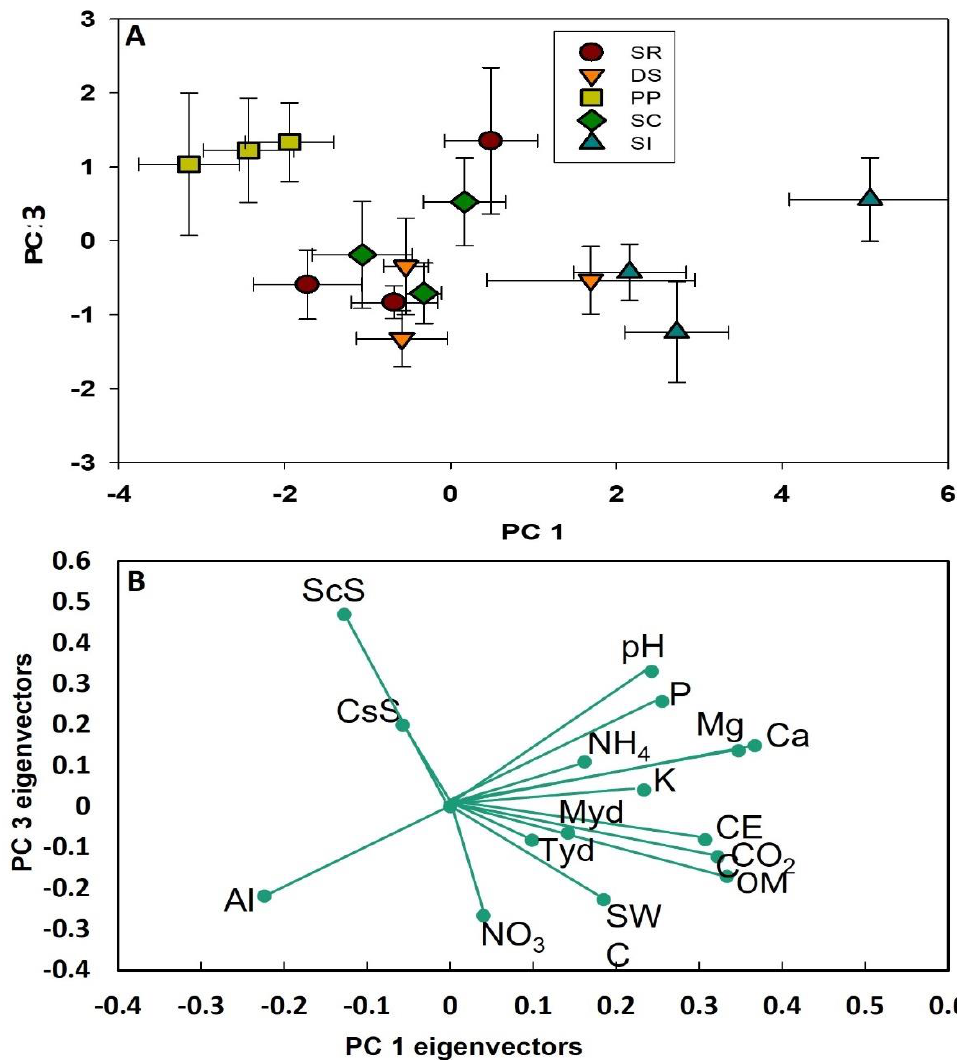
Figure 5. ( A ) Effects of cropping system (SQ—standard rotation, SC—soil conserving, SI—soil improving, DS—disease suppressive, and PP—nonrotation control) on crop and soil properties, as represented by principal components (PCs) 1 and 3 from principal components analysis assessed in each of three cropping years (2016–2018); and ( B ) PC eigenvectors for each soil property representing the loading factor contributing to the total variability for PCs 1 and 3 (Al, P, K, Mg, Ca, NO 3 , NH 4 indicate respective soil nutrient concentrations, OM = organic matter content, CO 2 = CO 2 respiration, CEC = cation exchange capacity, SWC = soil water content, ScS = black scurf severity, CsS = common scab severity, Tyd = total tuber yield, Myd = marketable tuber yield).